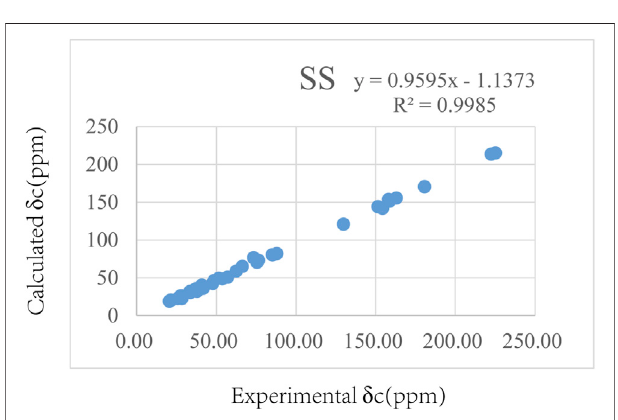
FIGURE 4 | Regression analysis of the experimental and calculated 13 C chemical shifts for 1 .